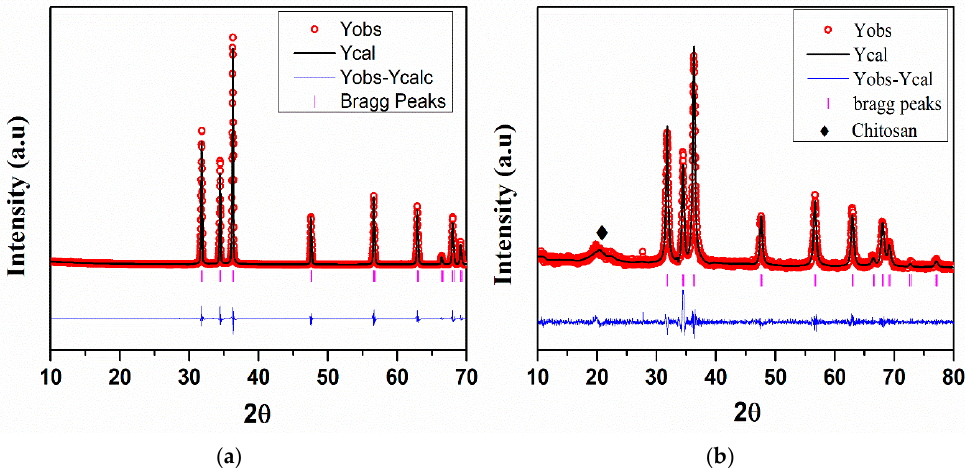
Figure 1. XRD pattern of ZnO NPs ( a ) and Chitosan ‐ ZnO NPs ( b ).